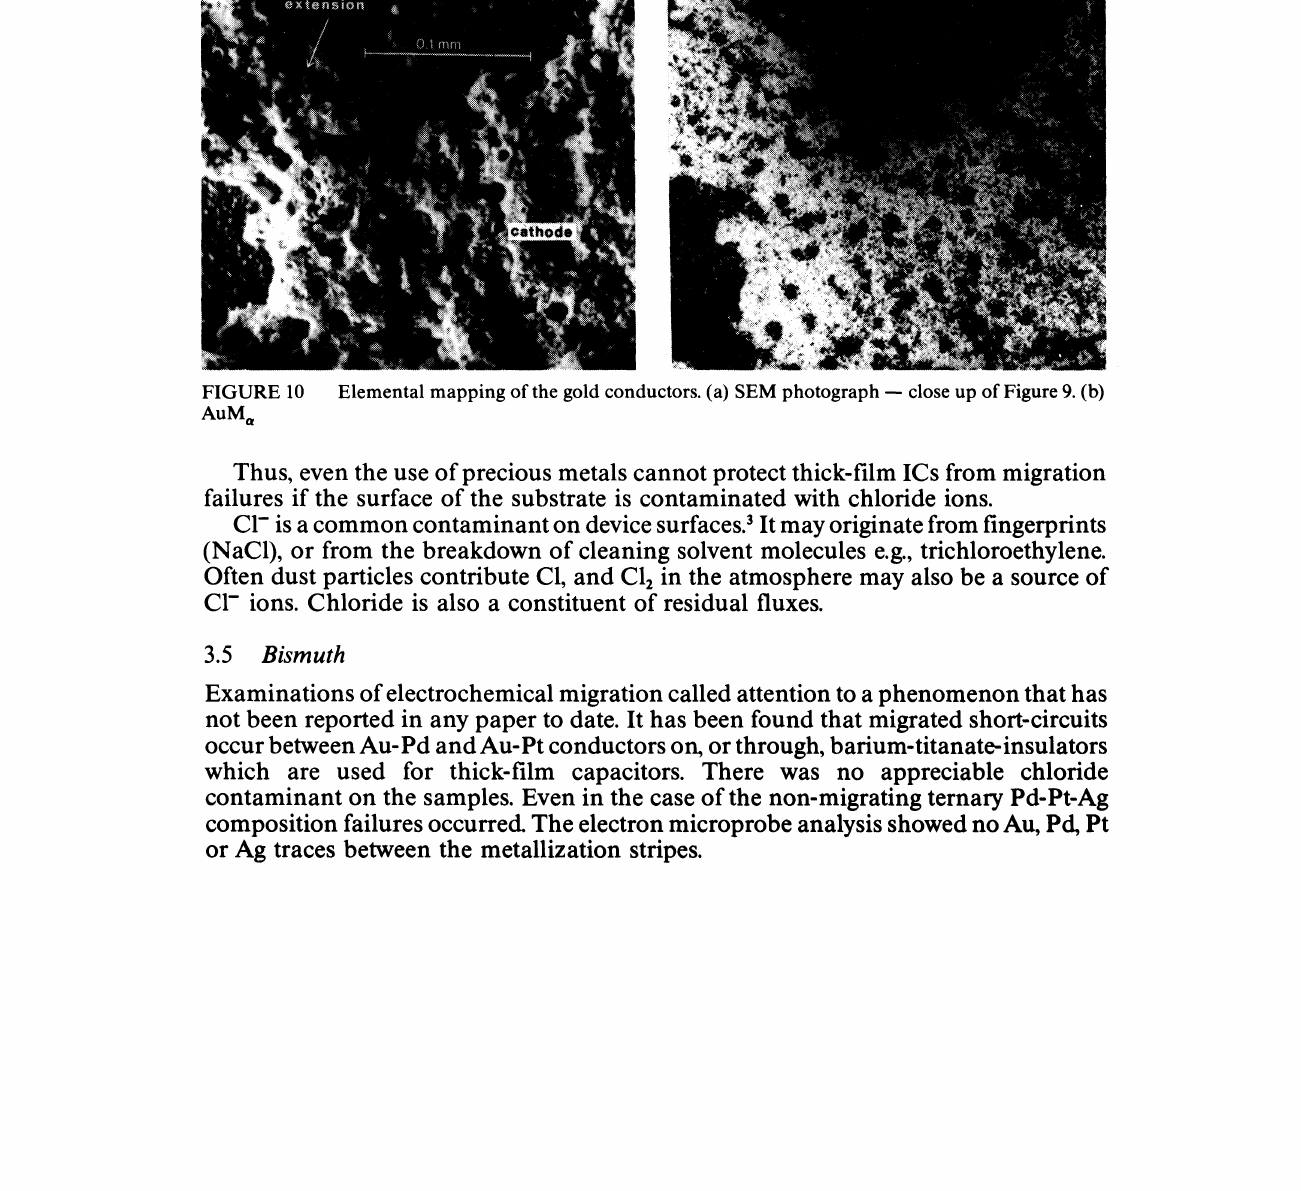
FIGURE 8 Close up of a copper dendrite. FIGURE 9 Gold migration (SEI).